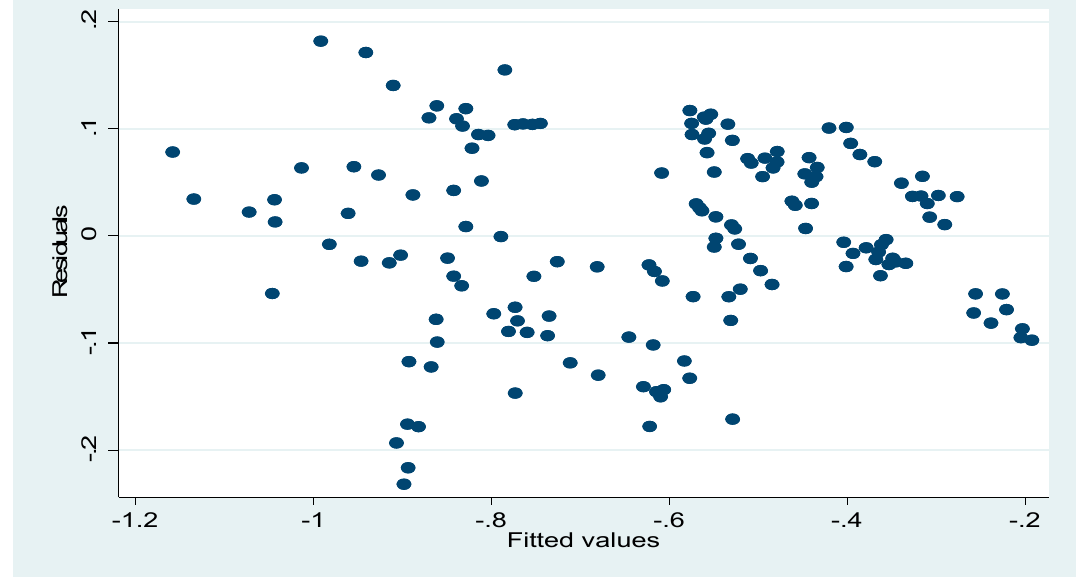
Figure 11. Residual-fitted values plot. Source: World Bank data group.